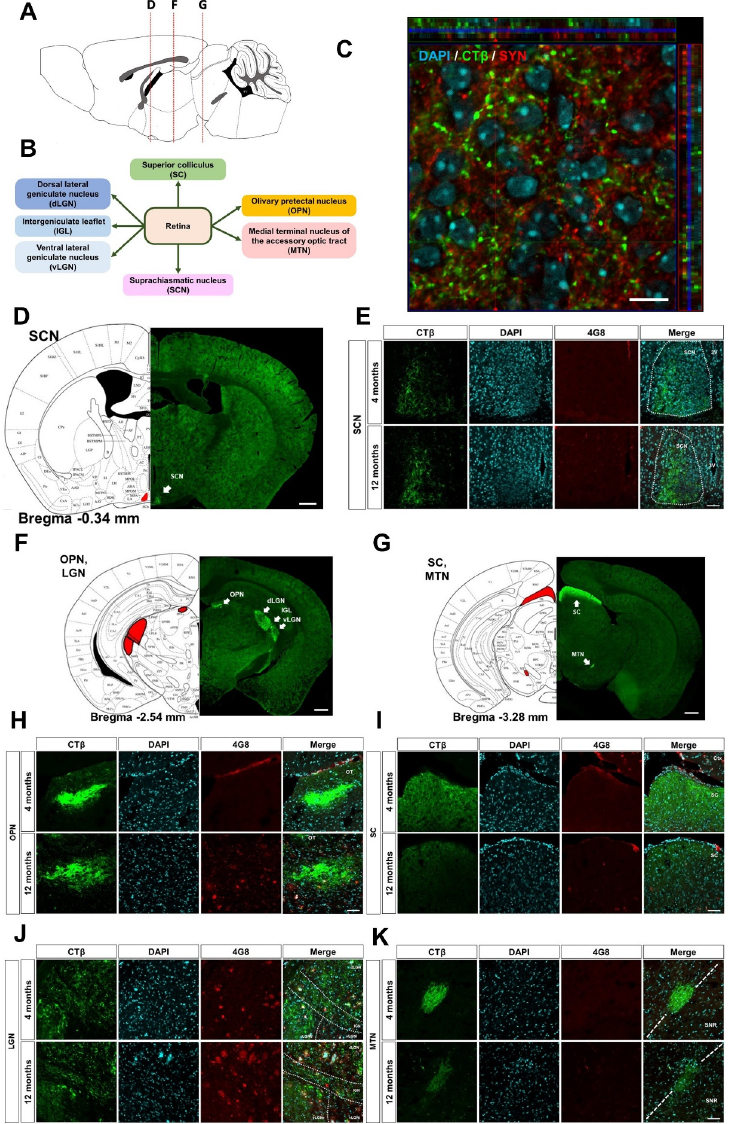
Figure 2. Histological profiling of the CT β and A β deposition in the retinorecipient regions. ( A ) The sagittal plane of the mouse brain indicates the positions of the representative Figure 2 in ( D , F , G ). ( B ) The schematic diagram indicates the projection from the retina to the retinorecipient regions of the brain. CT β -positive signals represent the retinal output to the ( D ) SCN, ( F ) OPN/LGN, and ( G ) SC/MTN in the brain hemisphere. Scale bar = 500 µ m. ( C ) The representative orthogonal view shows that CT β co-localizes with the presynaptic vesicular protein synaptophysin (SYN) in the SCN. Green indicated CT β -positive signals. Red signals showed SYN-positive signals. The side and bottom panels, respectively, depict the y − z and x − z cross-sectional images. Scale bar = 10 µ m. Representative images show the deposition of A β plaques stained with 4G8 antibody in the ( E ) SCN, ( H ) OPN, ( I ) SC, ( J ) LGN, and ( K ) MTN of 4- and 12-month-old 5XFAD groups. Scale bar = 50 µ m. The dotted line in ( J ) indicates the sub-region of the LGN. LGN is divided into dLGN, IGL, external and internal vLGN. ( K ) MTN is located at the boundary of SNR. dLGN, dorsal lateral geniculate nucleus; IGL, intergeniculate leaflet; LGN, lateral geniculate nucleus; MTN, medial terminal nucleus of the accessory optic tract; OPN, olivary pretectal nucleus; OT, nucleus of the optic tract; SC, superior colliculus; SCN, suprachiasmatic nucleus; SNR, substantia nigra pars reticula; vLGN, ventral lateral geniculate